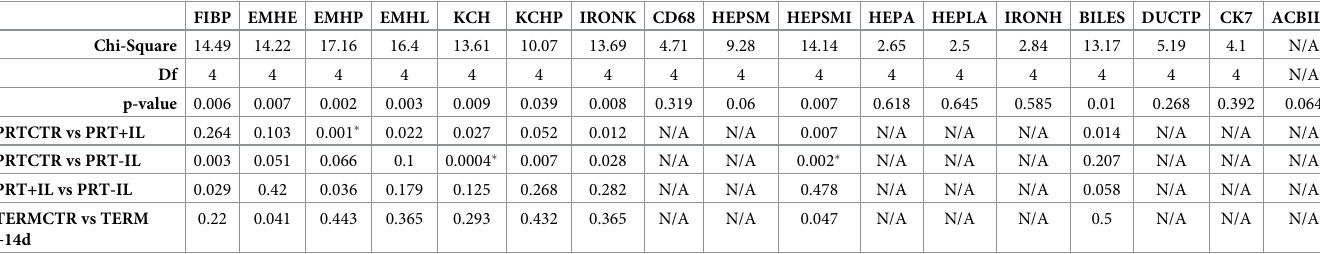
Table 4. Statistical analysis of liver histopathology